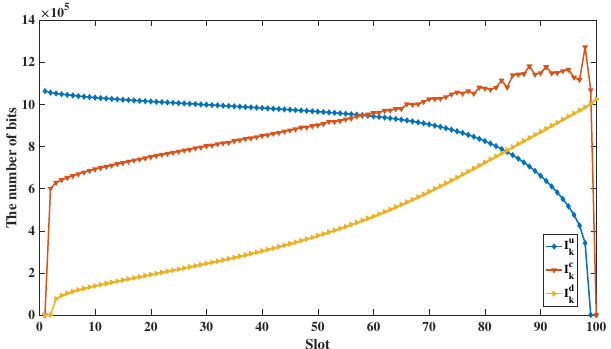
Figure 4. The bits allocation of user 1 under the proposed energy-efficient design of the UAV ( T = 5 s, P = 0.2 W).